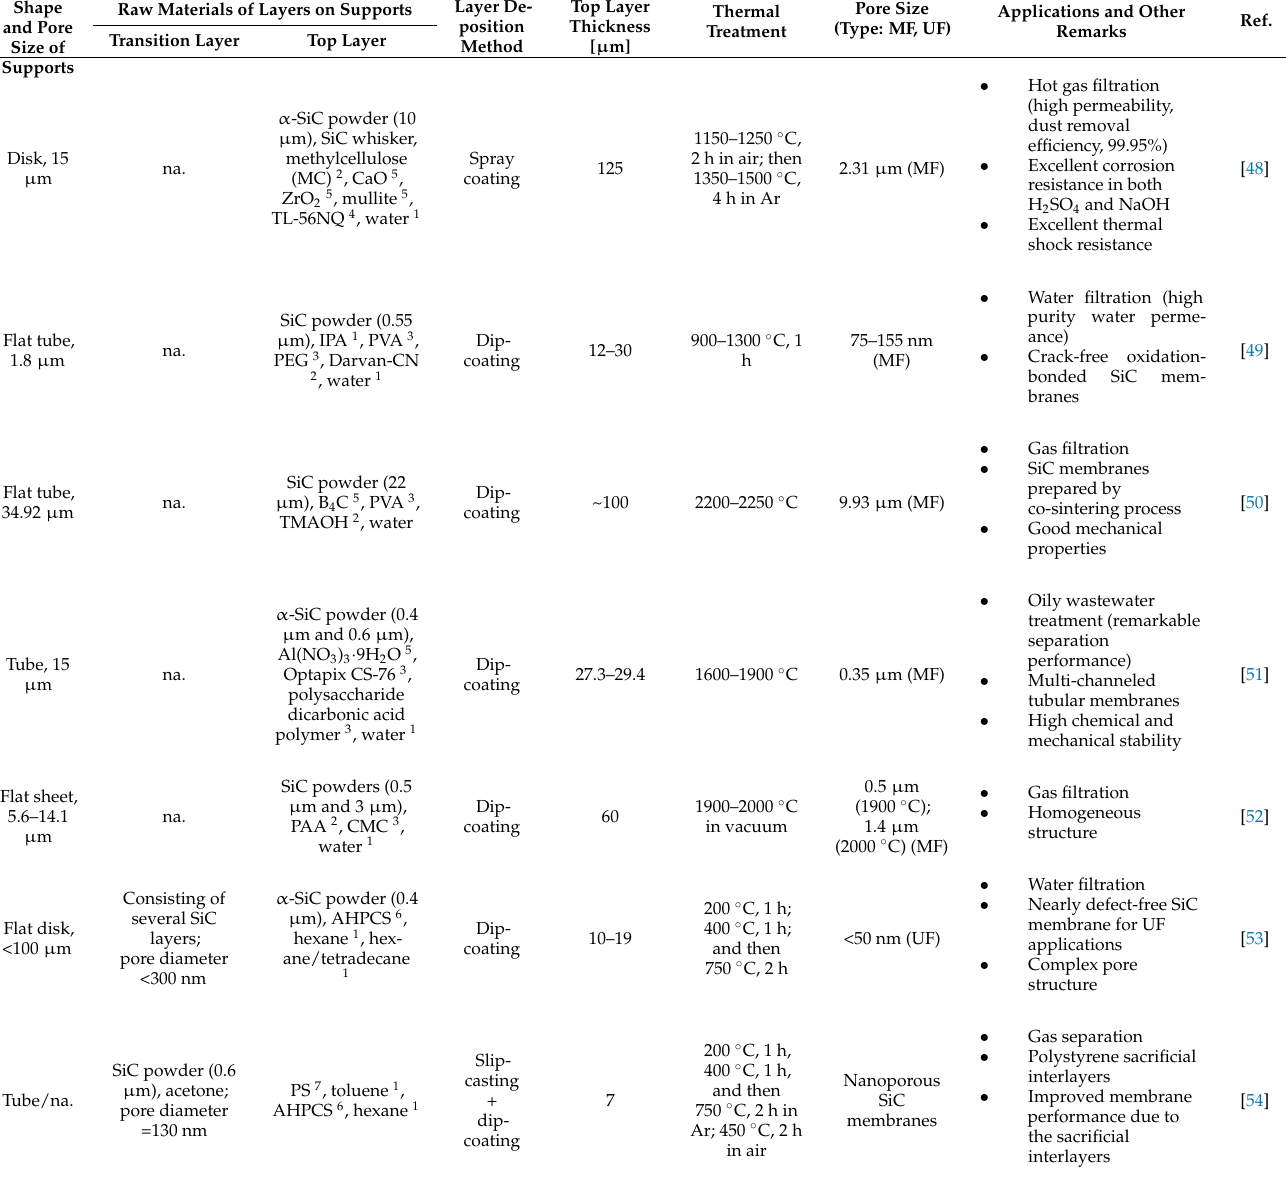
Table 2. Fabrication process and properties of representative SiC membrane filtrations (MF and